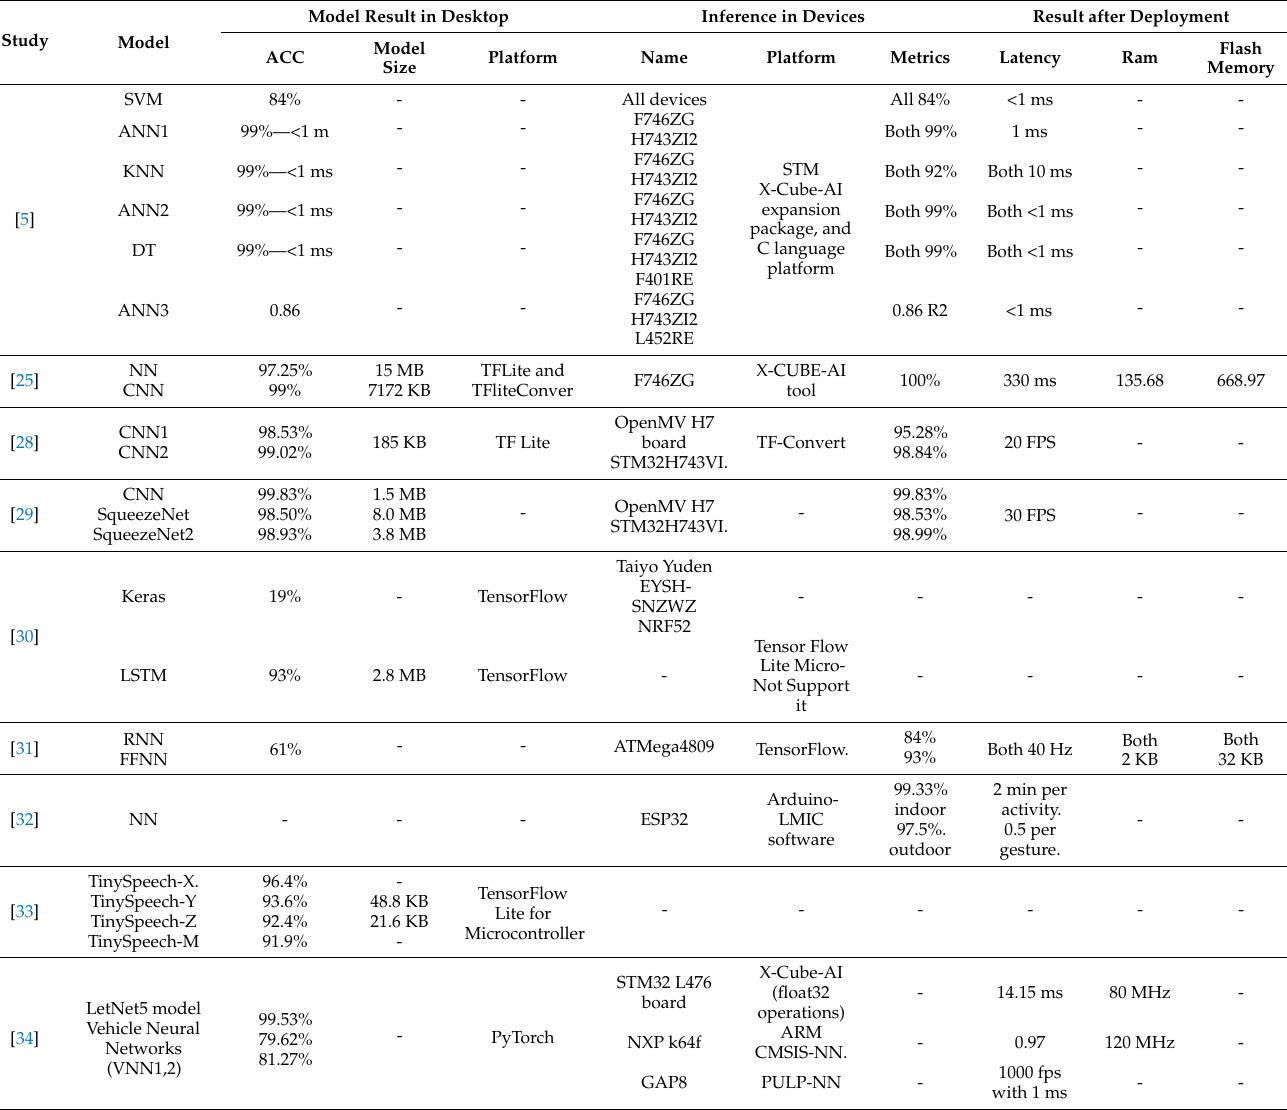
Table 2. Comparison between earlier studies related to DL methodologies based on the used models, the results, and the inference